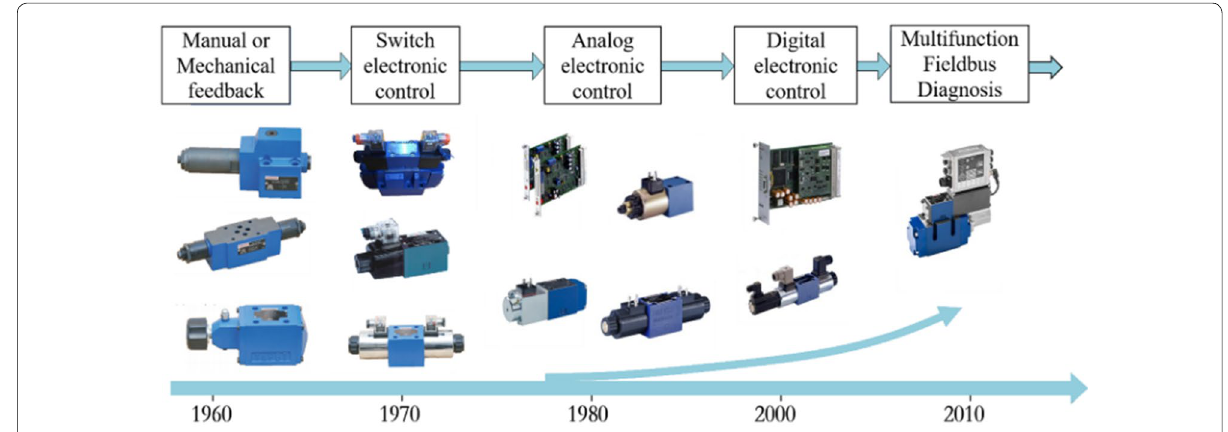
Figure 1 Development of electro-hydraulic control